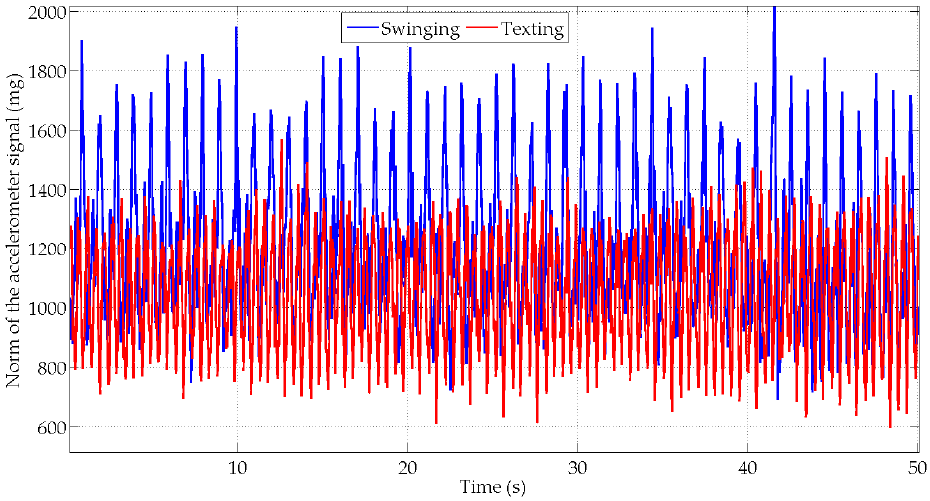
Figure 7. Norm of the accelerations for subject S1 in the texting (red) and swinging (blue) scenarios.